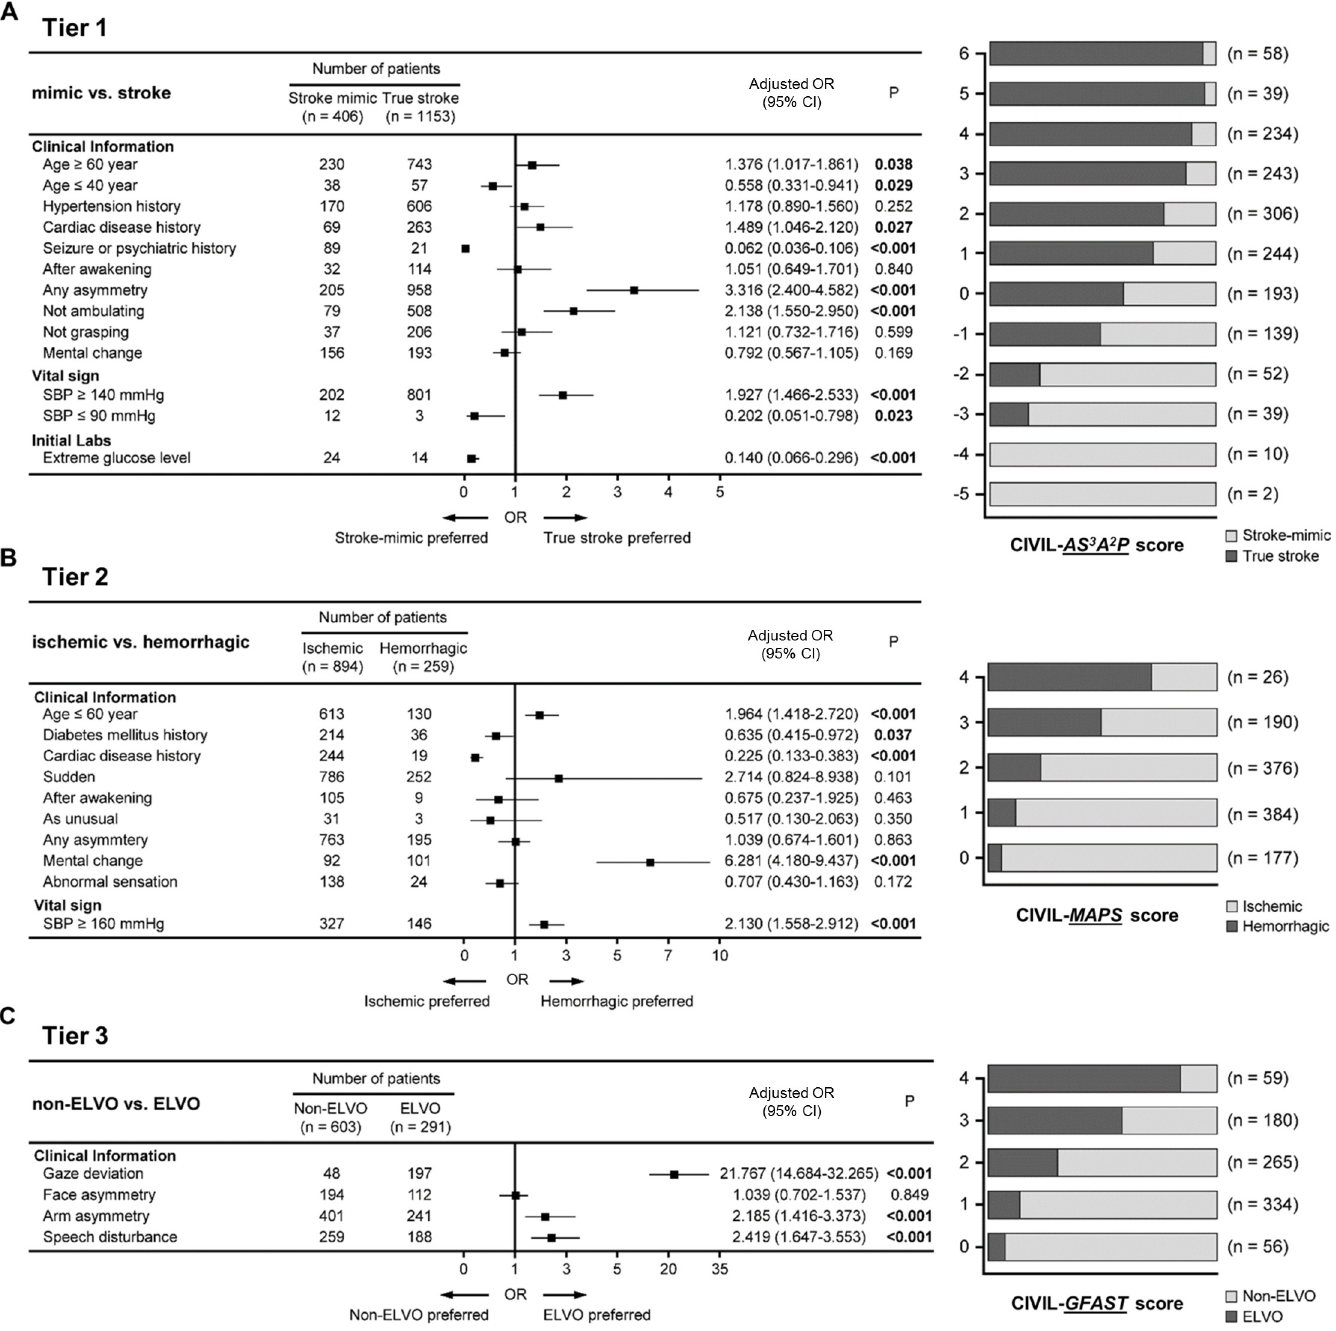
Fig 1. Results of multiple regression analysis and distribution of patients according to the CIVIL scores. (A) Tier 1: CIVIL -AS 3 A 2 P score consisted of A ge ( � 40 years or � 60 years), S troke risk (cardiac disease history) without S eizure or psychiatric history, extreme S ugar level ( � 80 or � 400mg/dl), any A symmetry, not A mbulating, and P ressure (SBP � 90 mmHg or � 140mmHg). (B) Tier 2: CIVIL -MAPS included M ental change, A ge ( � 60 years), P ressure (SBP � 160mmHg), and no S troke risks (history of diabetes mellitus or cardiac disease). (C) Tier 3: To identify emergent large vessel occlusion patients, GFAST score was incorporated into the CIVIL scoring system ( G aze, F ace asymmetry, A rm asymmetry, S peech disturbance).